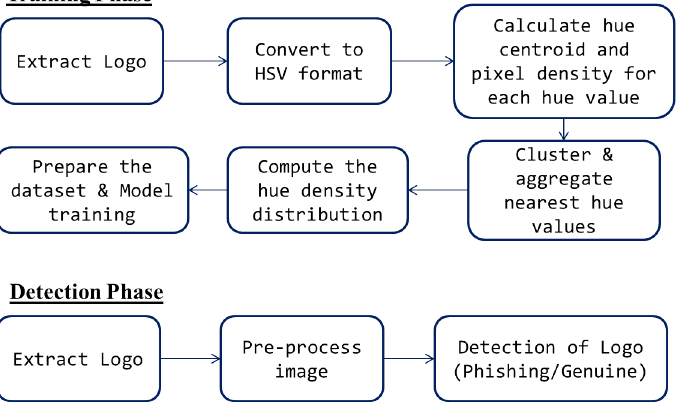
Figure 5. Flow diagram of the proposed approach. Hue refers only to the pure spectrum color names found on the color wheel: red, orange, yellow, green, blue and violet [33]. The hue value representation uses a range of 0–360 integer value to represent the original pigmentation of a pixel as shown in Figure 6. A single integer representation of a color empowers us to extract and use other associated features of the logo image for efficient detection. Once an image I is transformed to its equivalent hue, saturation and value (HSV) format, say I hsv , the list of distinct hue values HL I present in the image is obtained. For each hue value h i in the HL I hsv and the centroid position of all the pixels sharing the hue value h i is